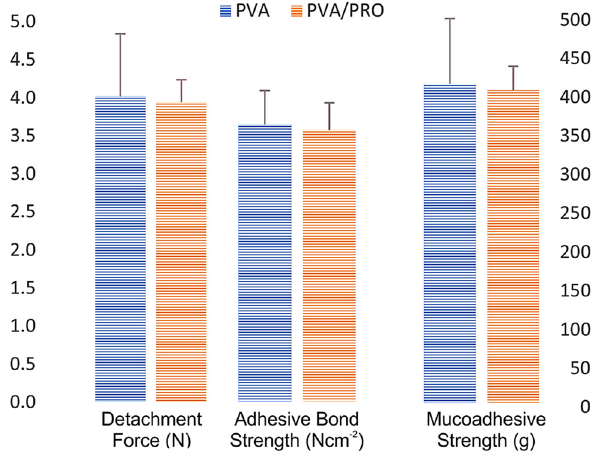
Figure 6: Ex vivo adhesive results of loaded electrospun mats: PRO 10% and PRO 15%.